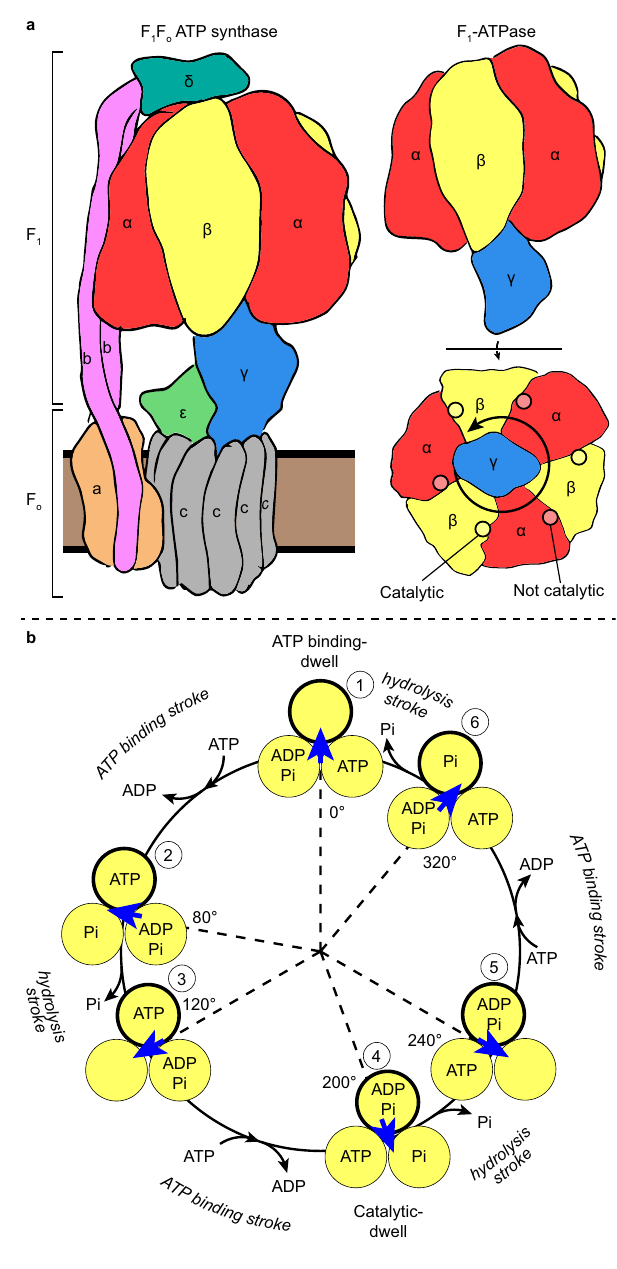
Fig. 1 Schematic of F 1 -ATPase architecture and function. a Schematic to show the overall arrangement of subunits in F 1 F o ATP synthase (left) and F 1 -ATPase (right). Direction of γ -subunit rotation in F 1 -ATPase during ATP hydrolysis is depicted with an arrow and the positions of the nucleotide- binding sites are highlighted and labeled (bottom right panel — viewed from the membrane, which is referred to as the “ below ” view hereafter). b Schematic of the F 1 -ATPase rotary catalytic mechanism, as suggested by single-molecule experiments. β -Subunits are depicted as yellow circles with binding site occupancy labeled, the γ -subunit is depicted with a blue arrow, and, for clarity, the α -subunits are not shown. The F 1 -ATPase γ -subunit rotates with six strokes alternating between 80° and 40° movements. The ATP-binding dwell precedes ATP binding and is followed by the “ ATP- binding stroke, ” whereas the catalytic dwell precedes the “ hydrolysis stroke. ” One of the β -subunits is outlined in black and at each dwell is numbered (from 1 to 6) to highlight the reaction path that a single subunit undergoes from the starting 0°